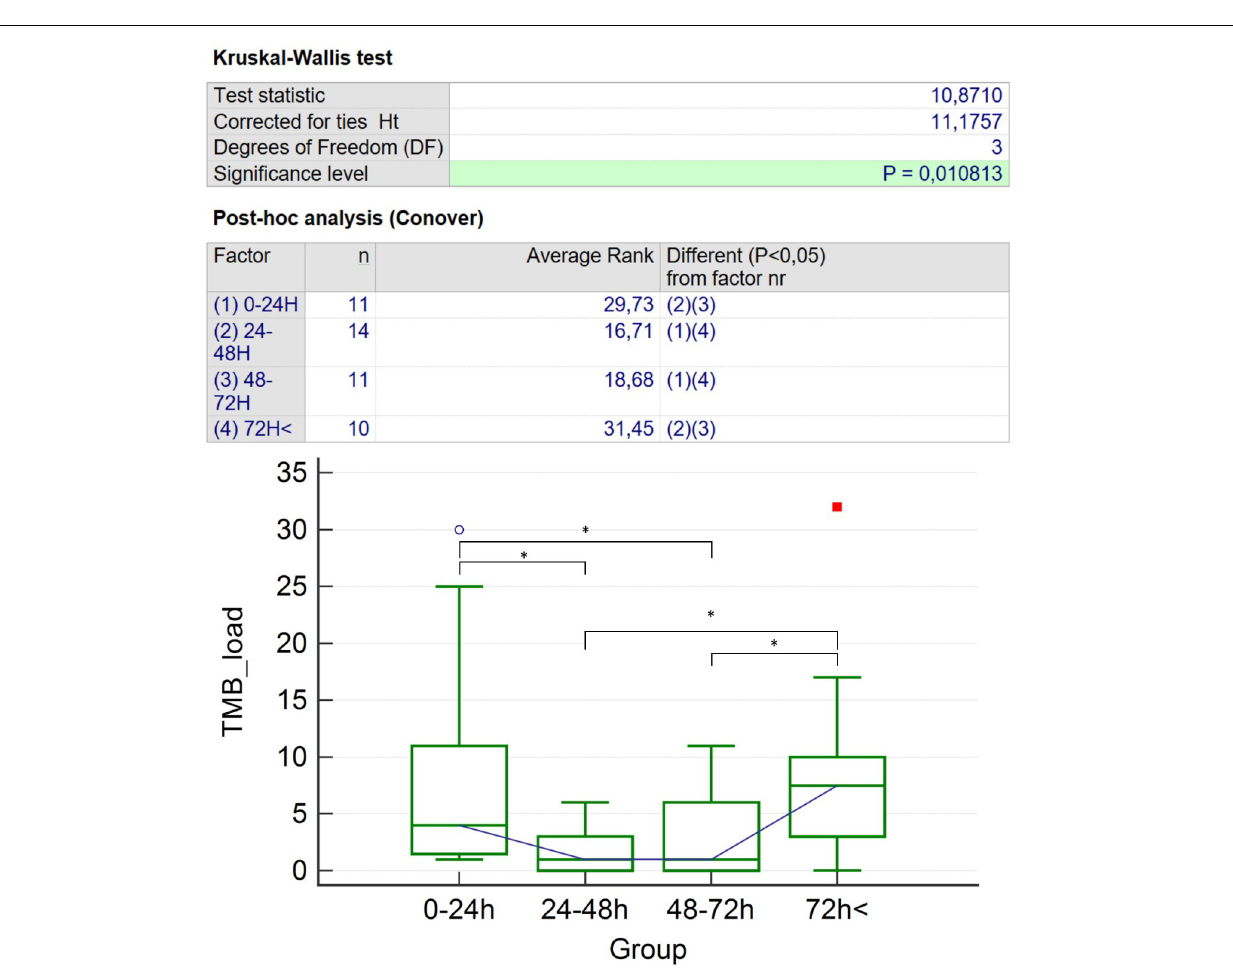
FIGURE 5 | Individual FLAIR lesion number over time, representing the second-order polynomial trend line. FLAIR, fluid-attenuated inversion recovery.